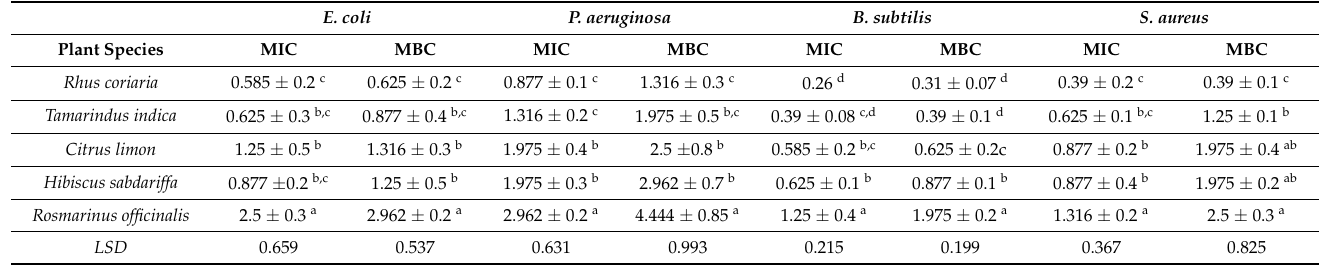
Table 4. The minimum inhibitory concentration (MIC) and minimum bactericidal concentration (MBC) of methanolic extracts (mg/mL).